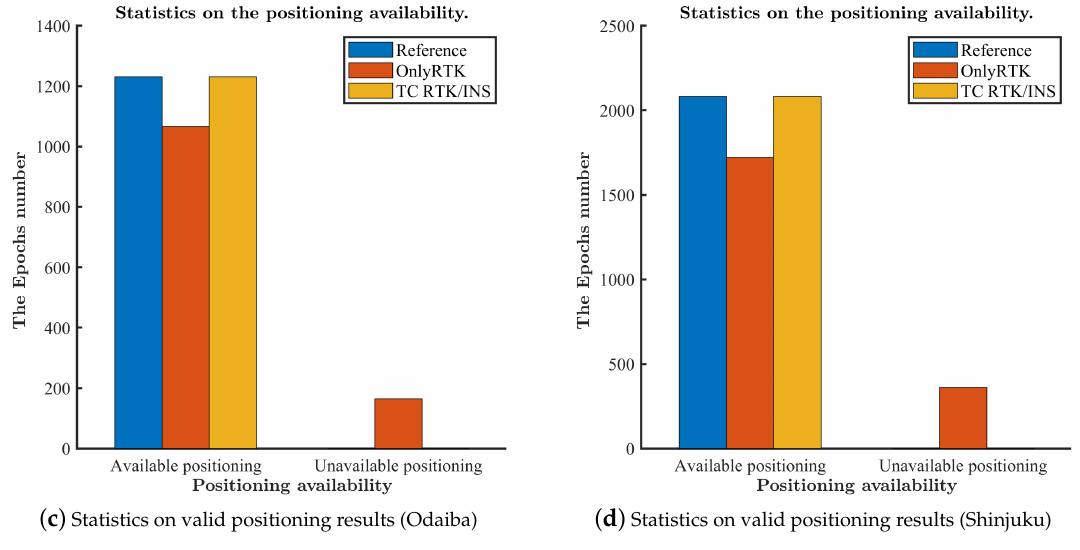
Figure 7. The positioning continuity comparison between RTK and TC RTK/INS.